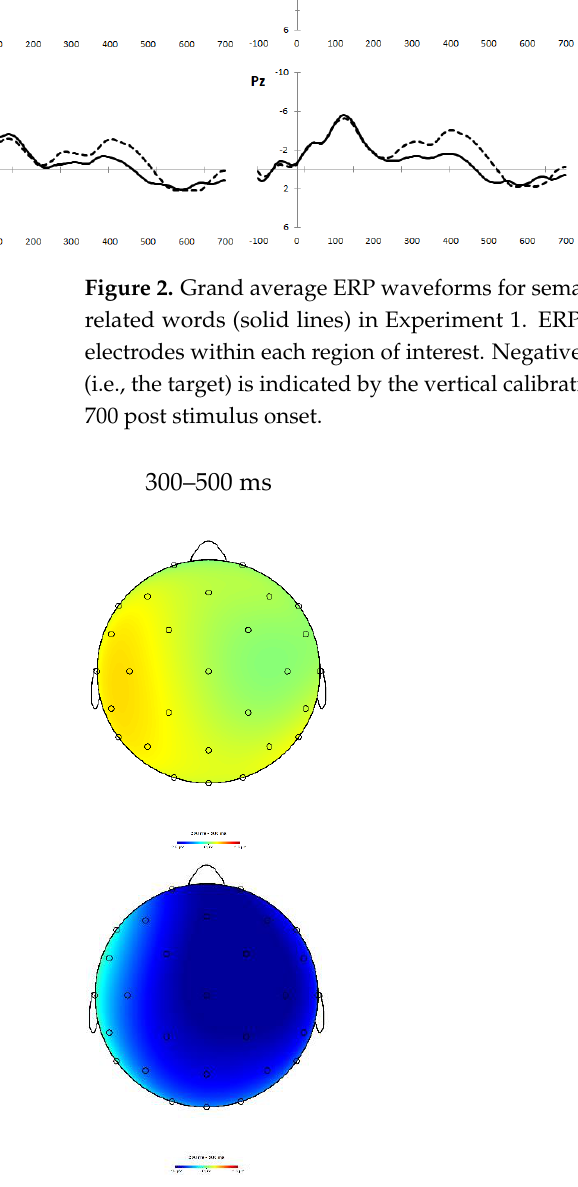
Figure 2. Grand average ERP waveforms for semantically unrelated (dotted lines) and semantically related words (solid lines) in Experiment 1. ERPs are plotted for nine equidistant representative electrodes within each region of interest. Negative voltage is plotted up. Onset of the Spanish word (i.e., the target) is indicated by the vertical calibration bar. Data are plotted from 100 ms prior to and 700 post stimulus onset.